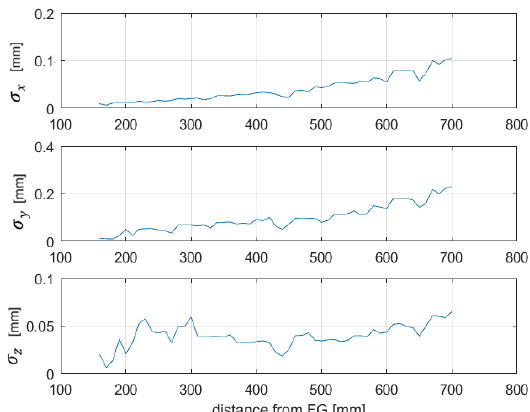
points lie on the z-axis .